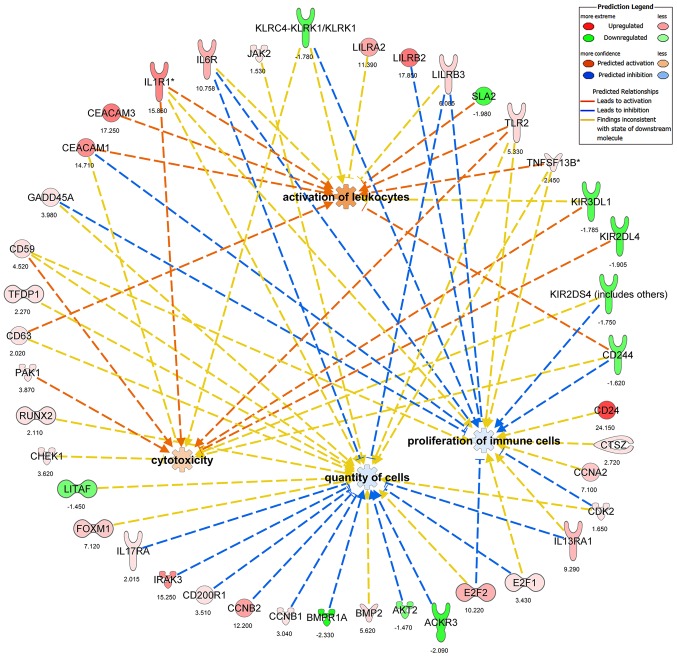
Ingenuity Pathway Analysis (IPA) Downstream Effects Analysis-based network associated with high-ranking natural killer (NK) cell functions. The NK cell functions (‘immune cells’, ‘quantity of cells’, ‘activation of leukocytes’, and ‘cytotoxicity’) in the IPA-defined Diseases and Bio Functions category were biologically relevant to a set of 41 NK cell function-related genes that were differentially expressed between first- and third-trimester peripheral blood NK (pNK) cells. Edges and nodes are color-coded based on the predicted relationship as indicated in the Prediction Legend. Numbers below symbols represent the fold changes in the transcript level of third- relative to first-trimester pNK cells.